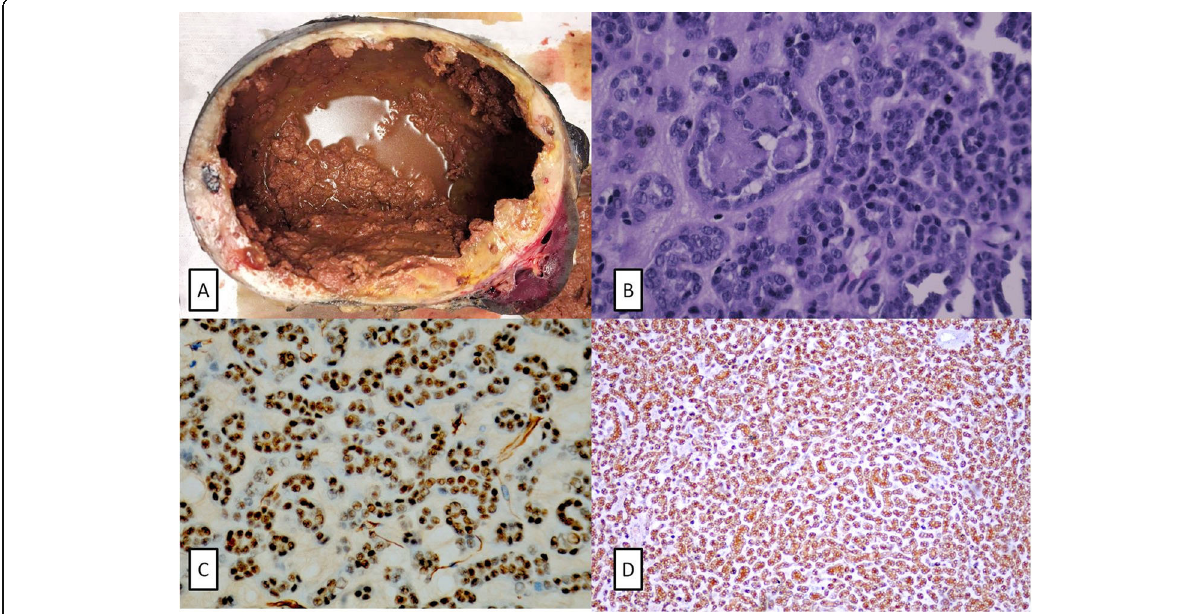
Fig. 6 Metanephric adenoma. The gross appearance was of a predominantly cystic tumor in this particular case ( a ). Microscopy shows small tubules and glomeruloid structures ( b HE, 400x). Characteristic immunoprofile includes diffuse staining for WT1 ( c 100x) and BRAF VE1,